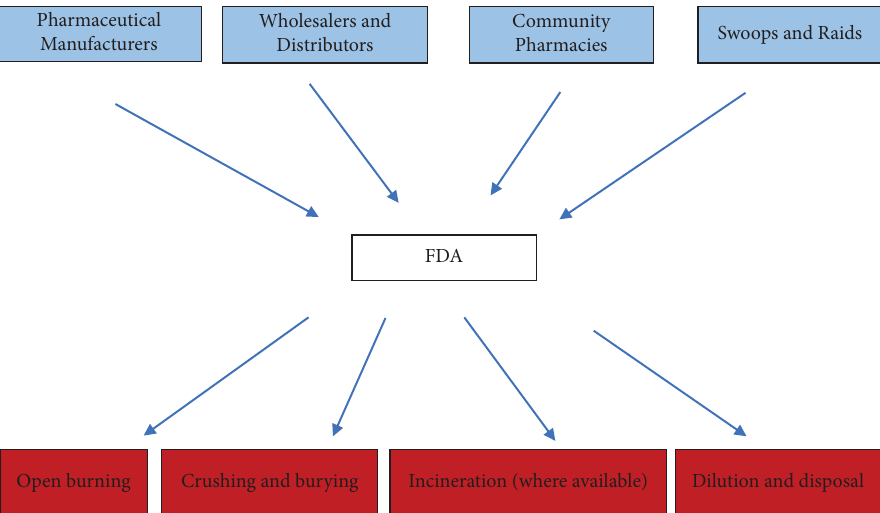
Figure 6: Flow of medicines during regulated disposal–from source to sink. Source: author (from KII with